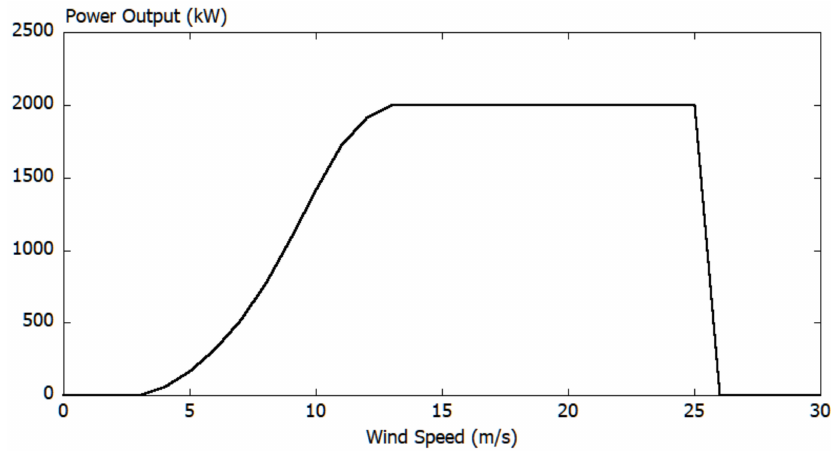
Figure 26. Power curve of the 2 MW wind turbine power curve.